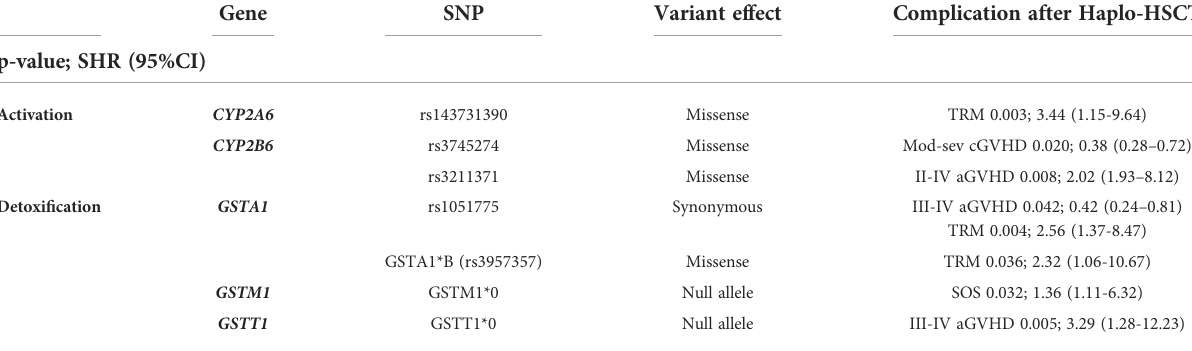
TABLE 4 Multivariable analysis for outcomes after Haplo-HSCT with